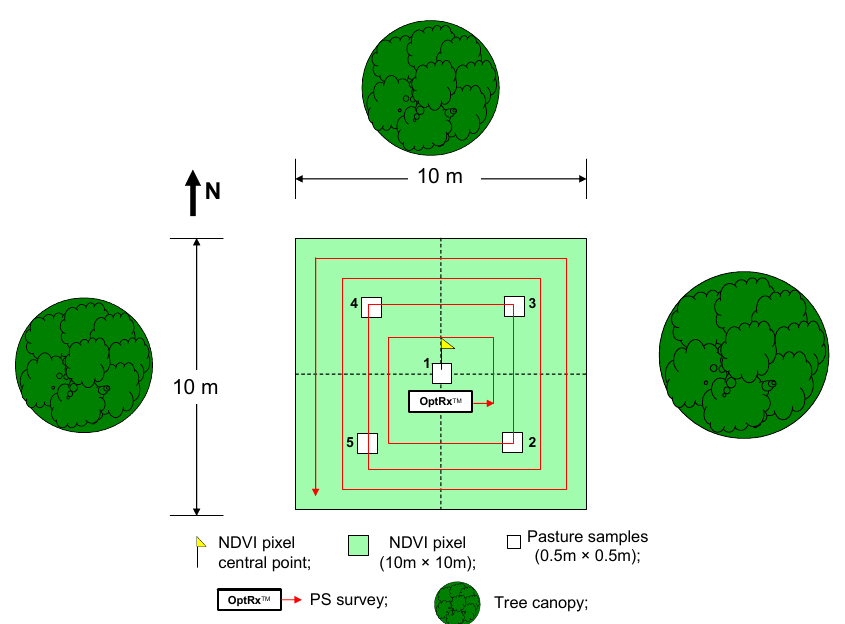
Figure 7. Sampling area: remote sensing, proximal sensing, and pasture samples.